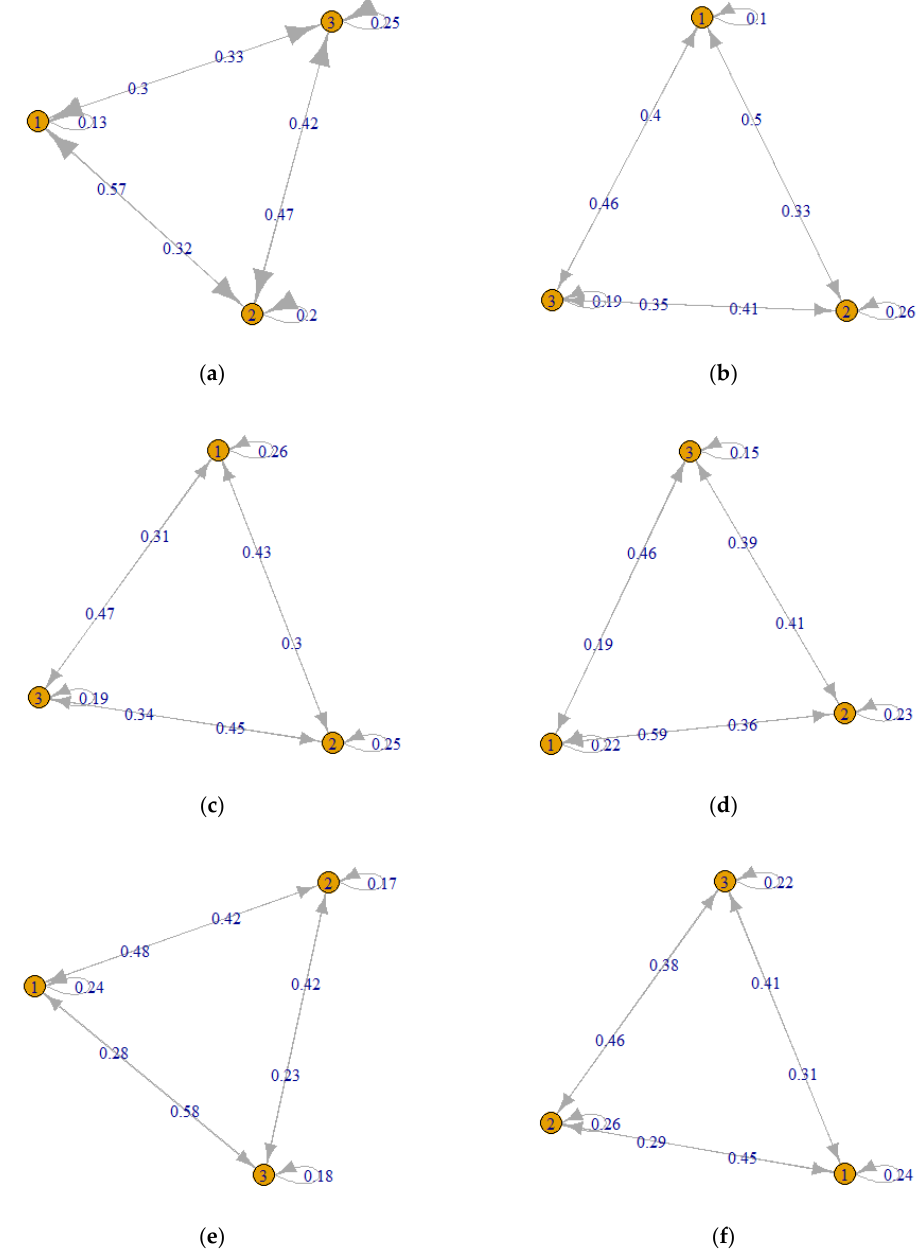
Figure 1. Markov chains with transition diagrams for the considered machines: ( a ) Machine M 1 ; ( b ) Machine M 2 ; ( c ) Machine M 3 ; ( d ) Machine M 6 ; ( e ) Machine M 7 ; ( f ) Machine M 8 .